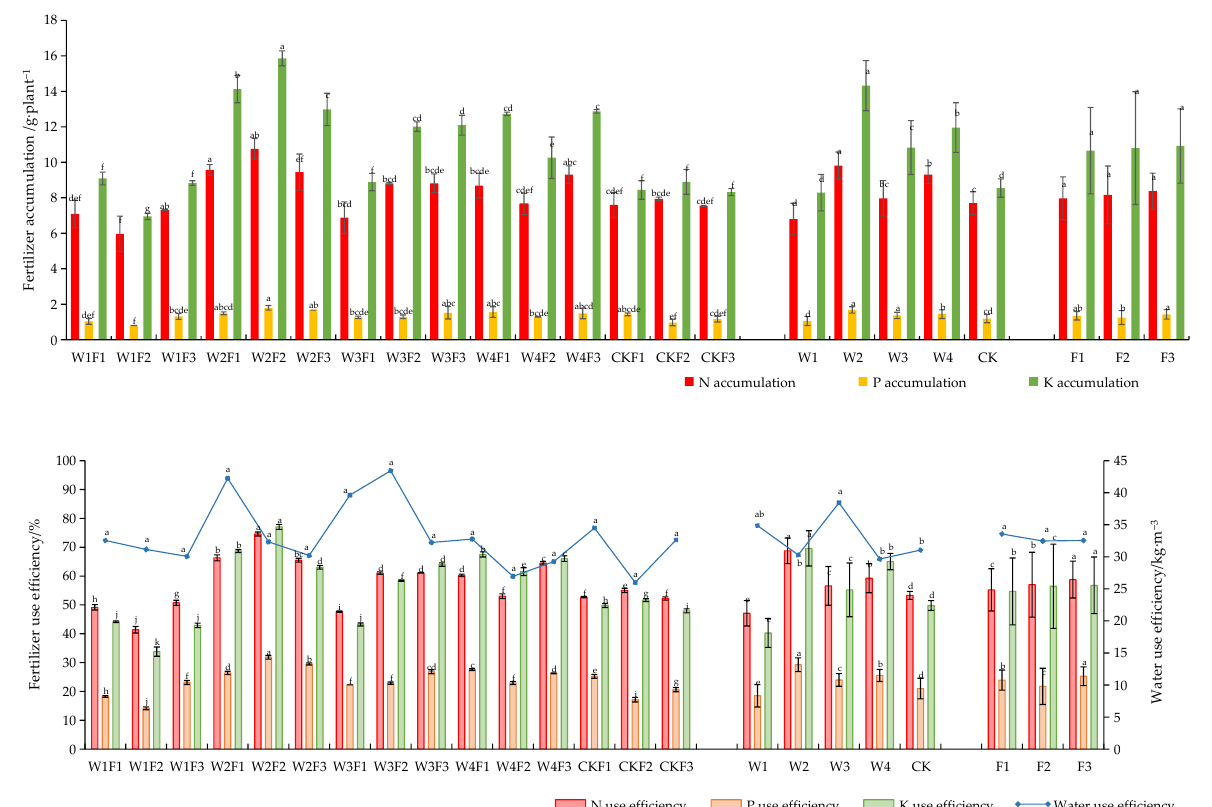
Figure 6. Effect of different treatments on irrigation water use effciency and nutrient use efficiency of tomatoes. Different lowercase letters in the same column indicate significant differences among treatments ( p < 0.05). Values with the same letters are not significantly different. The multiplication sign represents there is an interaction effect. The detailed data can be found at Appendix A.